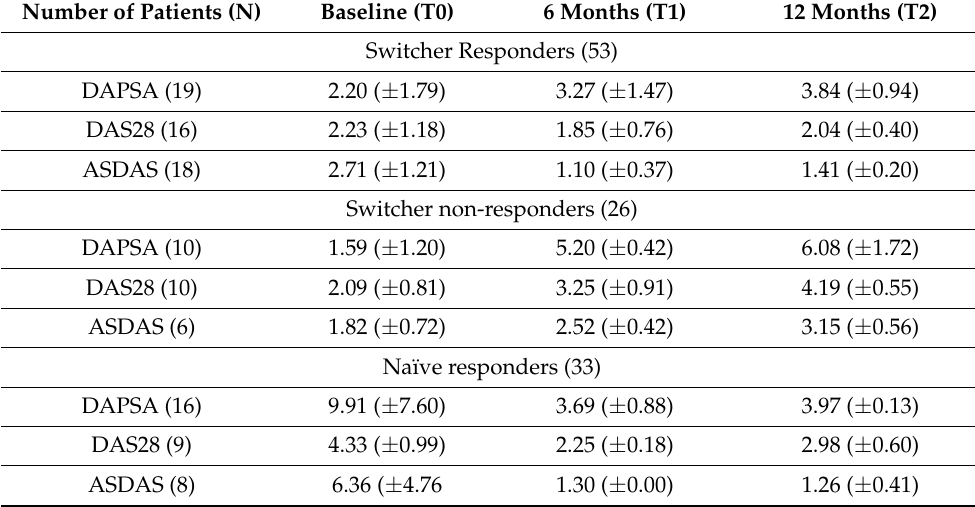
Table 2. DAPSA, DAS28, and ASDAS values of PsA, RA, AS patients (respectively) in switcher responder, switcher non-responder, naïve responder, and naïve non-responder